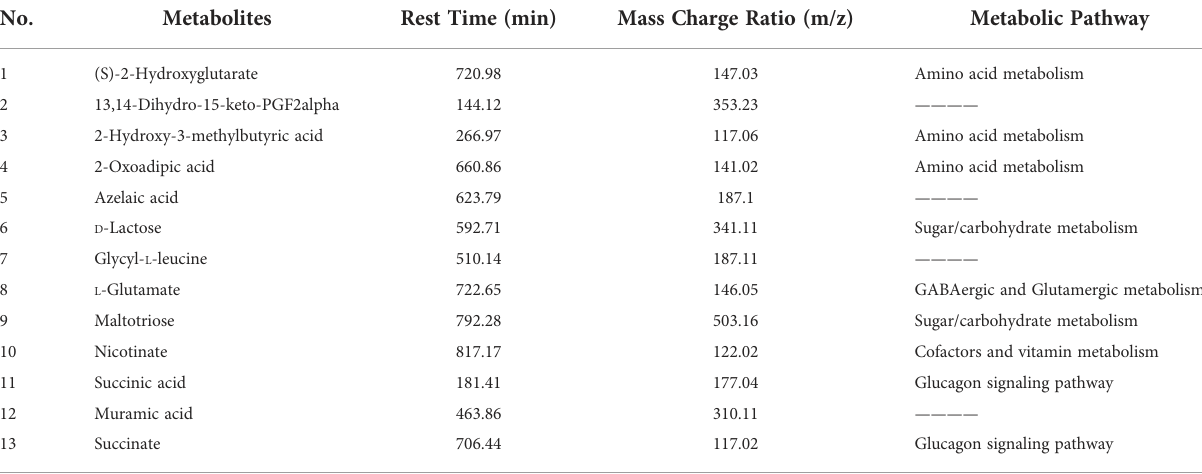
TABLE 3 Differentially expressed metabolites and their metabolic pathways according to variable importance in projection (VIP)